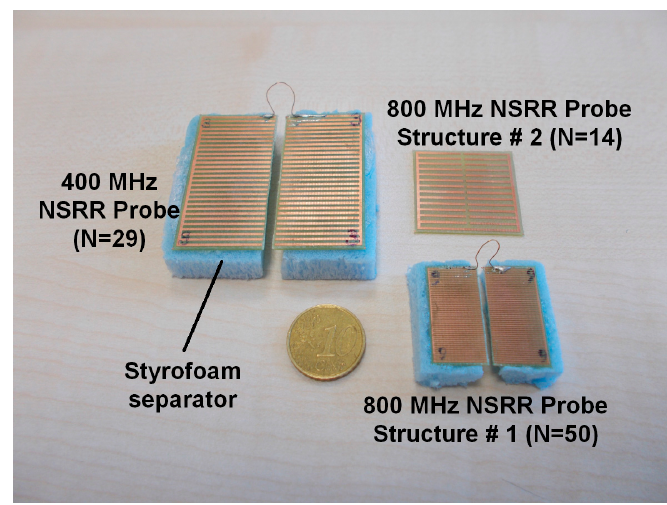
Figure 2. Displacement sensors designed in comb-like nested split-ring resonator (NSRR) geometry. Three different structures are shown. These vary in size and operating frequency. N is the number of the nested split-rings.